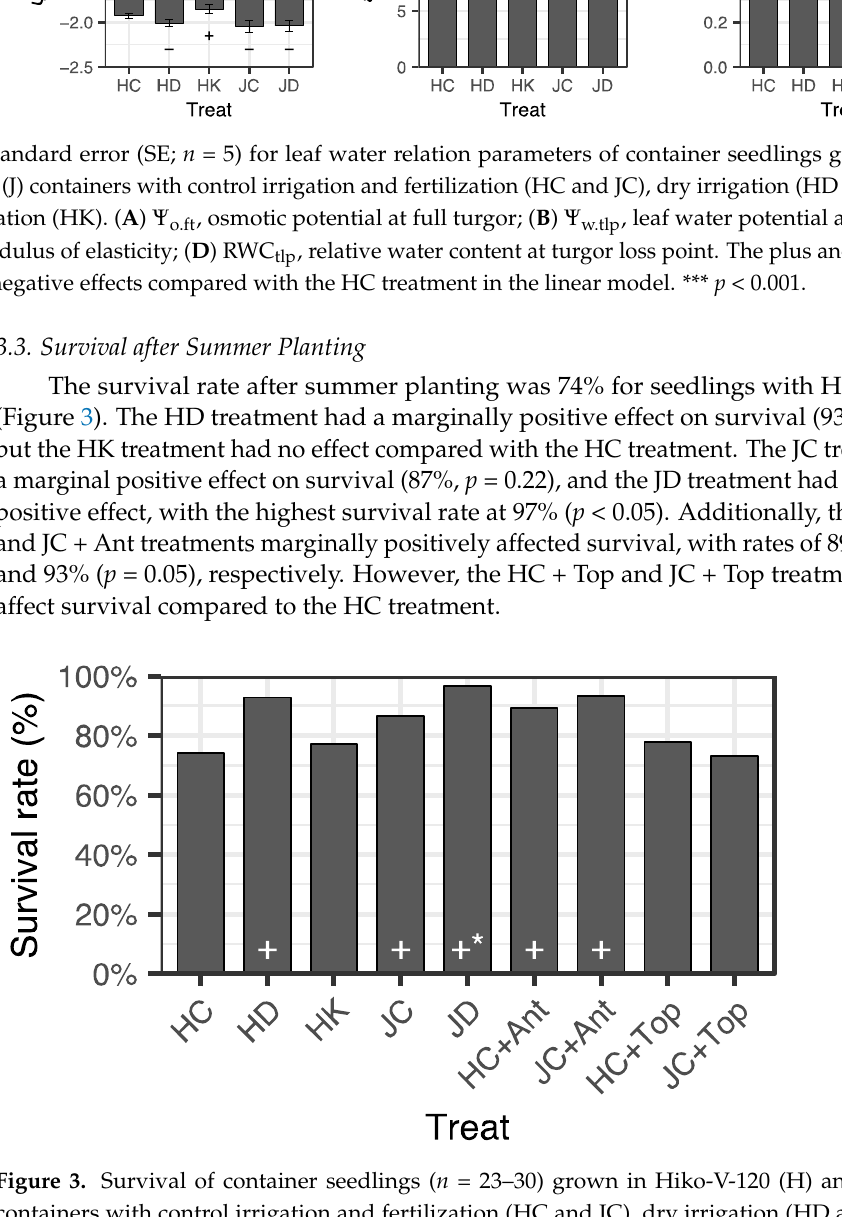
Figure 2. Mean values ± standard error (SE; n = 5) for leaf water relation parameters of container seedlings grown in Hiko- V-120 (H) and JFA-150 (J) containers with control irrigation and fertilization (HC and JC), dry irrigation (HD and JD), and high-potassium fertilization (HK). ( A ) Ψ , osmotic potential at full turgor; ( B ) Ψ , leaf water potential at turgor loss o.ft w.tlp point; ( C ) ε , bulk modulus of elasticity; ( D ) RWC , relative water content at turgor loss point. The plus and minus signs max tlp indicate positive and negative effects compared with the HC treatment in the linear model. *** p < 0.001.